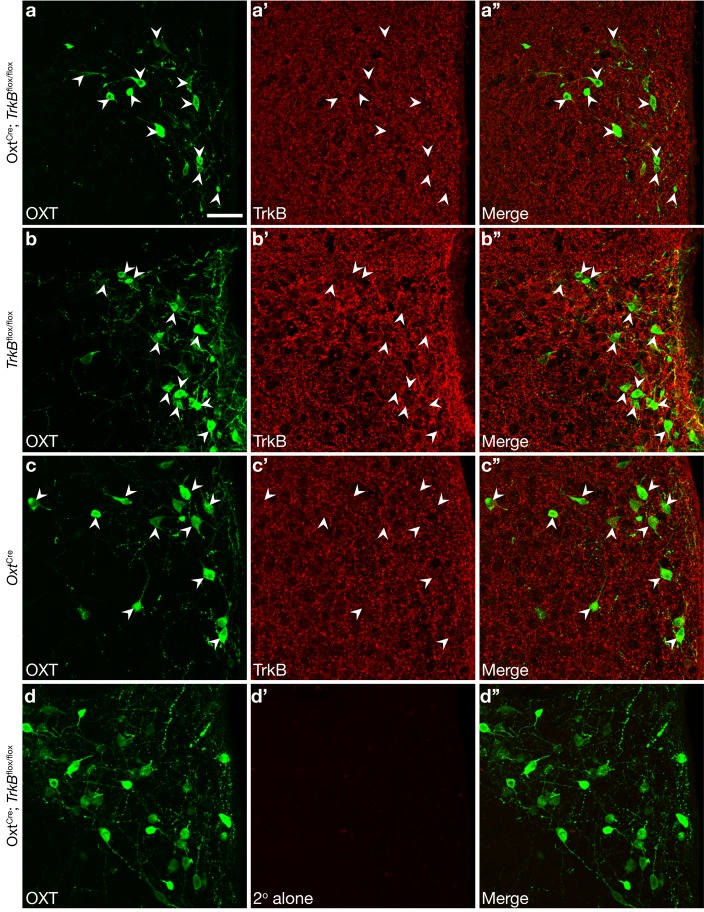
Ablation of TrkB protein in OXT neurons in OxtCre; TrkBflox/flox mice.(a-d) Confocal z-projections of PVN from OxtCre; TrkBflox/flox (a, d), TrkBflox/flox (b), and OxtCre (c) adult mice. Immunolabeling of OXT (a, b, c, d), TrkB (a’, b’, c’), and merged images (a”, b”, c”, d”). In control section (d’) the secondary antibody for TrkB has been omitted to demonstrate low background and absence of bleed through from the OXT channel. While TrkB shows robust cell surface and synaptic expression, it appears absent in OXT neuron cell bodies in OxtCre; TrkBflox/flox, but not TrkBflox/flox or OxtCre mice. Scale bar is 50 μm.